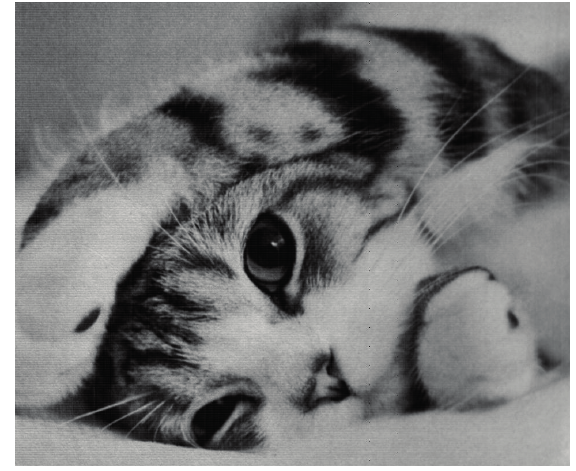
Figure 21. Sample image at the line rate of 15.5 k lines/s.